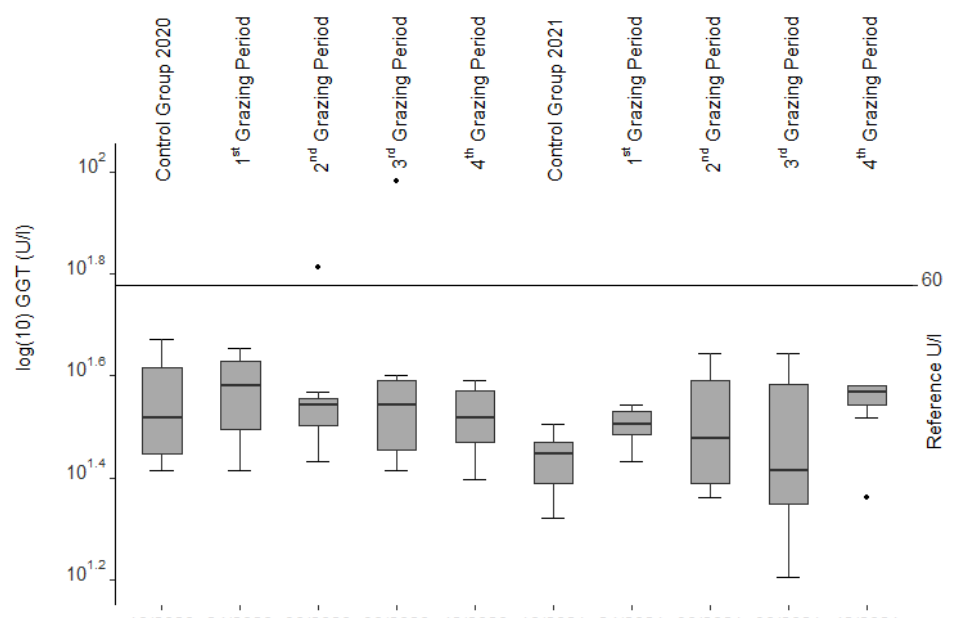
Figure 3. Glutamate dehydrogenase (GLDH) activities from blood serum of the slaughtered sheep.